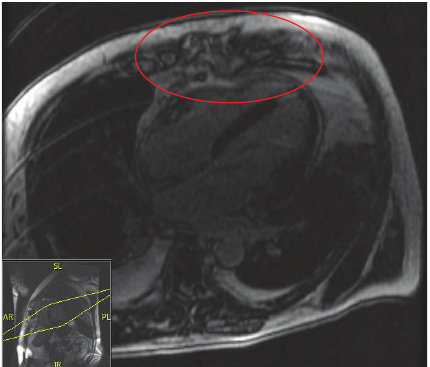
Figure 2: Cardiac MRI (four-chamber view) demonstrates a 1.5 cm small abscess contiguous with pericardial enhancement (red oval). Inset at bottom left demonstrates plane of cross-sectional image (SL = superolateral, PL = posterolateral, AR = anterior right, and IR = inferior